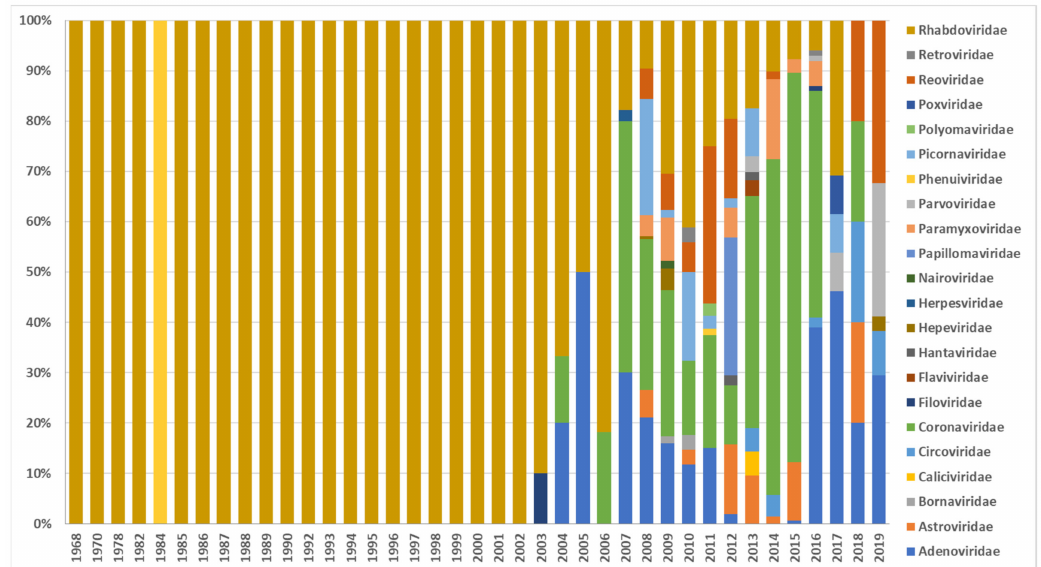
Figure 3. Published virus sequences by year of specimen collection, related to the respective viral family and order (DBatVir